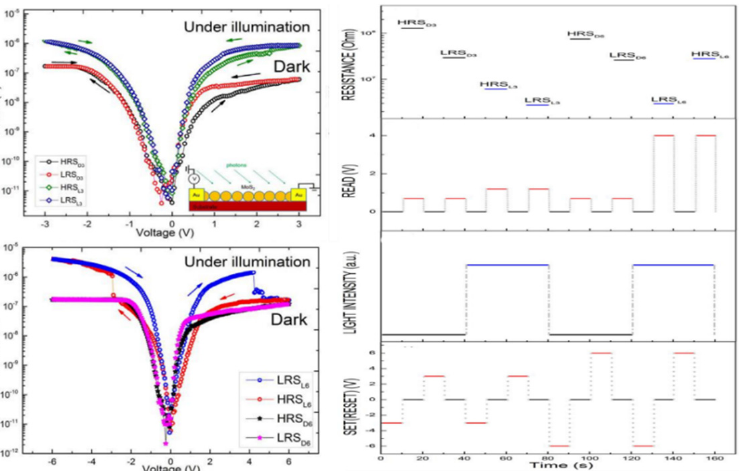
Figure 3. Current–voltage characteristics of the MoS 2 photomemristor polarized at 3V (left, top) and 6V (left, bottom) and switching diagrams (SET, RESET) of memristive states (HRS D3 , HRS L3 , LRS D3 , LRS L3 , HRS D6 , HRS L6 , LRS D6 , LRS L6 ) with electrical and optical excitation [15].